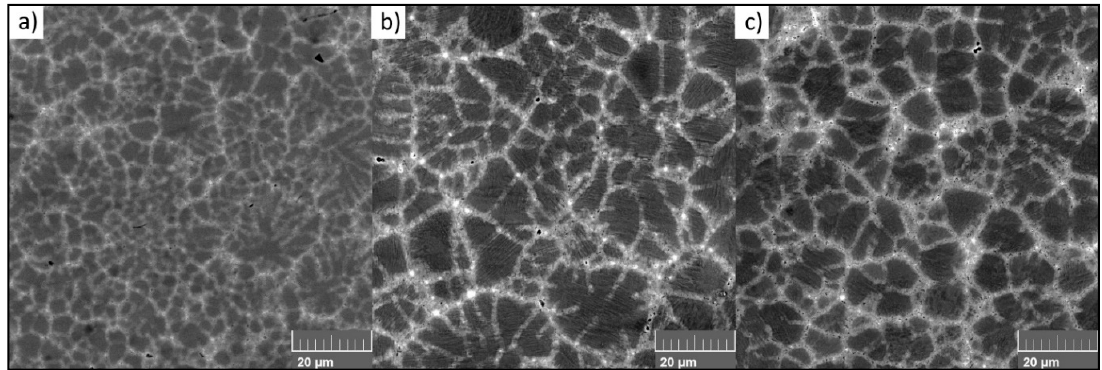
Figure 2. SEM images of as-cast samples (BSE mode): ( a ) alloy Al-1, ( b ) alloy Cr-1, ( c ) alloy Fe-1.